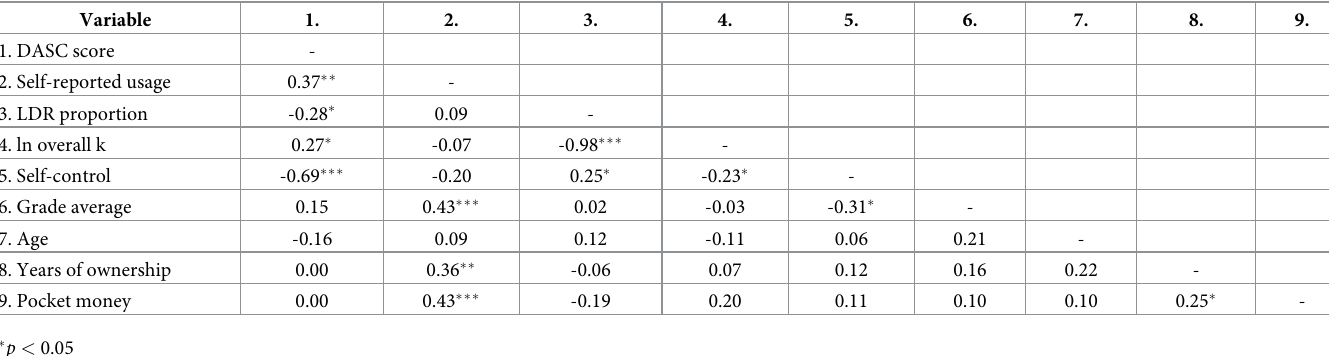
Table 2. Correlations between main